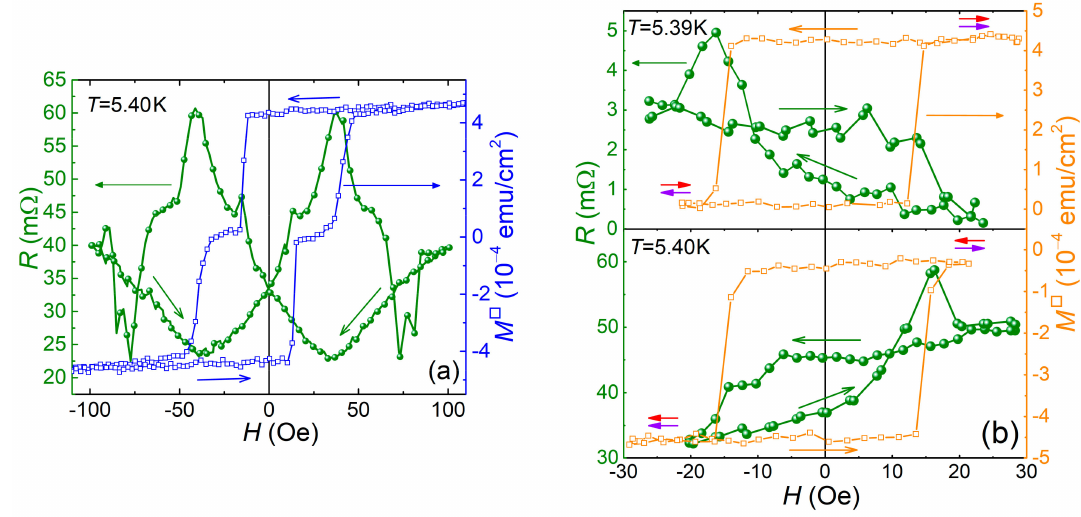
Figure 6. Dependence of electric resistance of the tri-layer MgO/Pd 0.96 Fe 0.04 /VN/Pd 0.92 Fe 0.08 /Si (S4) pseudo-spin-valve sample on the magnetic field: ( a ) remagnetization along the major magnetic hysteresis loop; and ( b ) remagnetization along the minor magnetic hysteresis